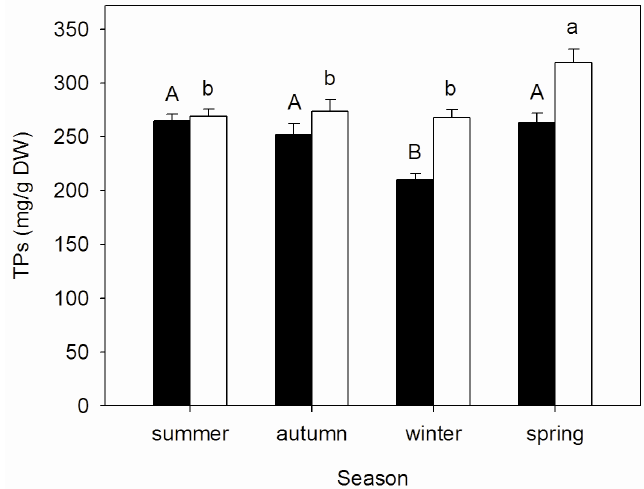
Figure 2. Seasonal changes in the total phenolics (TPs) concentrations in leaves of A. corniculatum . Symbols are black bars for mature leaves and white bars for senescent leaves. Different capital letters indicate significant differences among seasons for TPs concentrations in mature leaves at p < 0.05. Different lowercase letters indicate significant differences among seasons for TPs concentrations in senescent leaves at p < 0.05. Table 3. Correlations between total phenolics (TPs) and nutrient concentrations (N and P), and N:P ratios of A. corniculatum leaves.